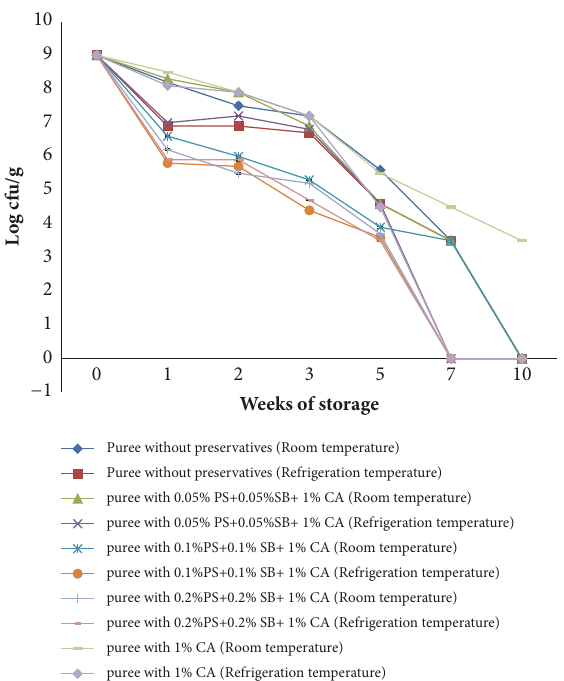
Figure 5: Total aerobic microorganisms in OFSP puree with preservatives during storage at ambient temperatures (15-25 ∘ C) and refrigeration temperature (4 ∘ C). PS : potassium sorbate, SB : sodium benzoate, and CA : citric acid.